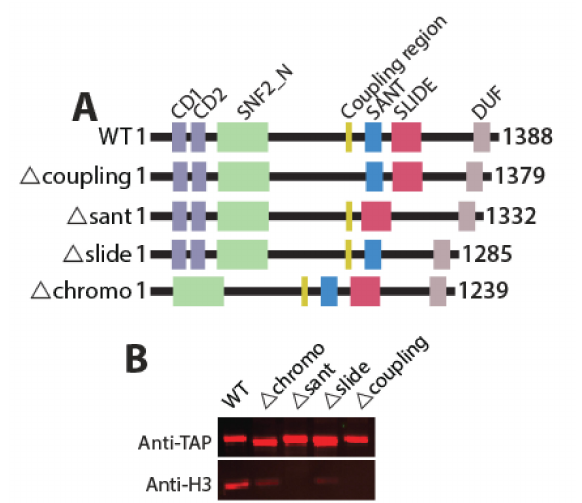
Figure 2. Schema of Hrp3 domain organization, their deletions to generate mutant Hrp3, and affinity purification of WT/mutant Hrp3 protein. ( A ) A schematic representation of Hrp3 with all domains (WT) and internal domain deletion (mutants). The change in the protein length of Hrp3 upon domain deletion is shown. Strains harboring these constructs are Hu2402 (WT), Hu3060 ( ∆ chromo), Hu3061 ( ∆ sant), Hu3062 ( ∆ slide) Hu3063 ( ∆ coupling) with complete genotypes indicated in Table 1. ( B ) Western blot showing the affinity-purified wild type and domain deleted Hrp3 proteins and co-purified histone